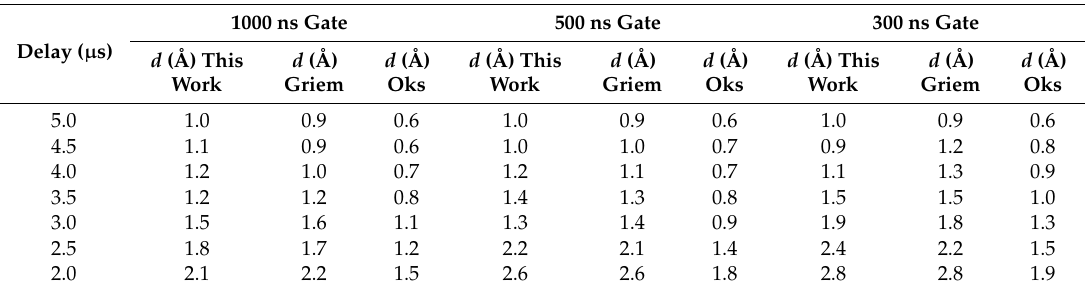
Table 4. Experimental Stark shifts of the H α -line obtained in this work compared to the theoretical values found in the